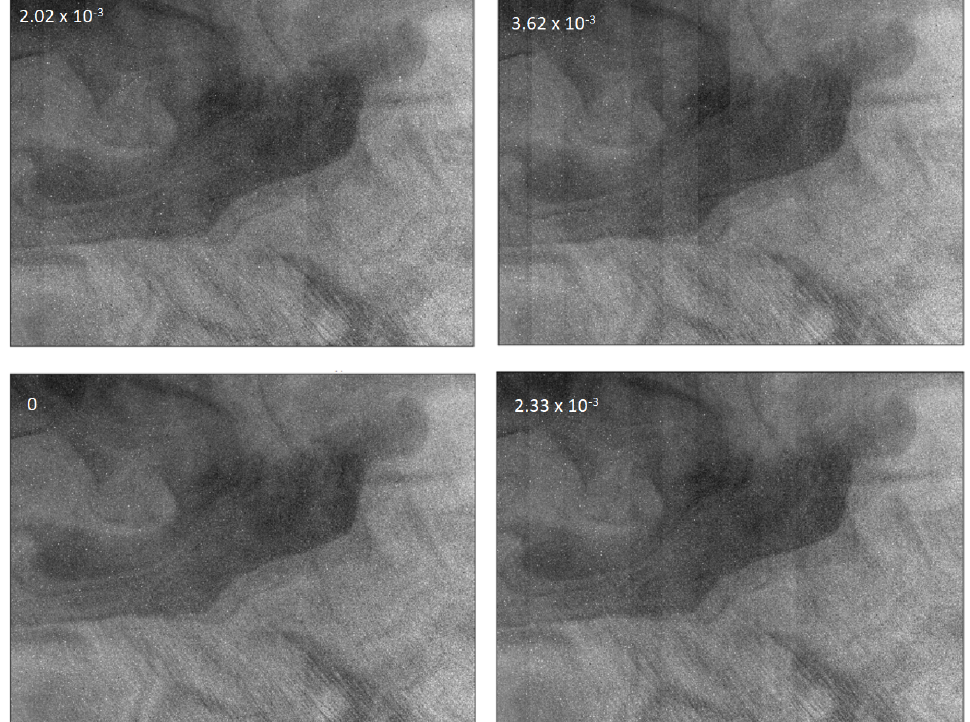
Figure 16. Contrast- stretched band 1 Mediterranean Sea image with: SS FPM gains applied ( Top Left ); CPF FPM gains applied ( Top Right ); In-Scene FPM gains applied ( Bottom Left ); modeled FPM gains applied ( Bottom Right ). In the top-left corner of each scene is the overlap detector metric for that